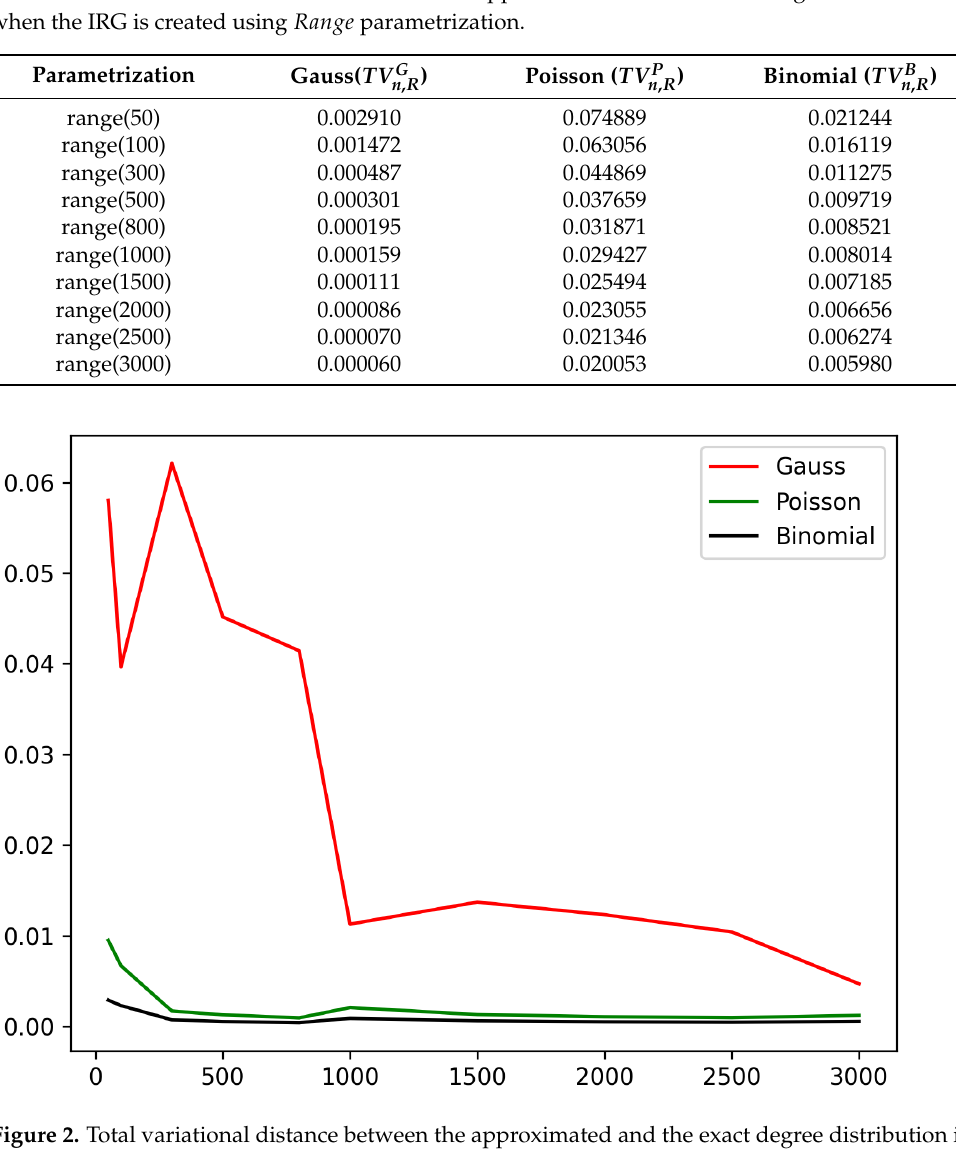
Figure 2. Total variational distance between the approximated and the exact degree distribution in the function of network size when the IRGs are generated by LognormalSeq parametrization of the biased static edge voting